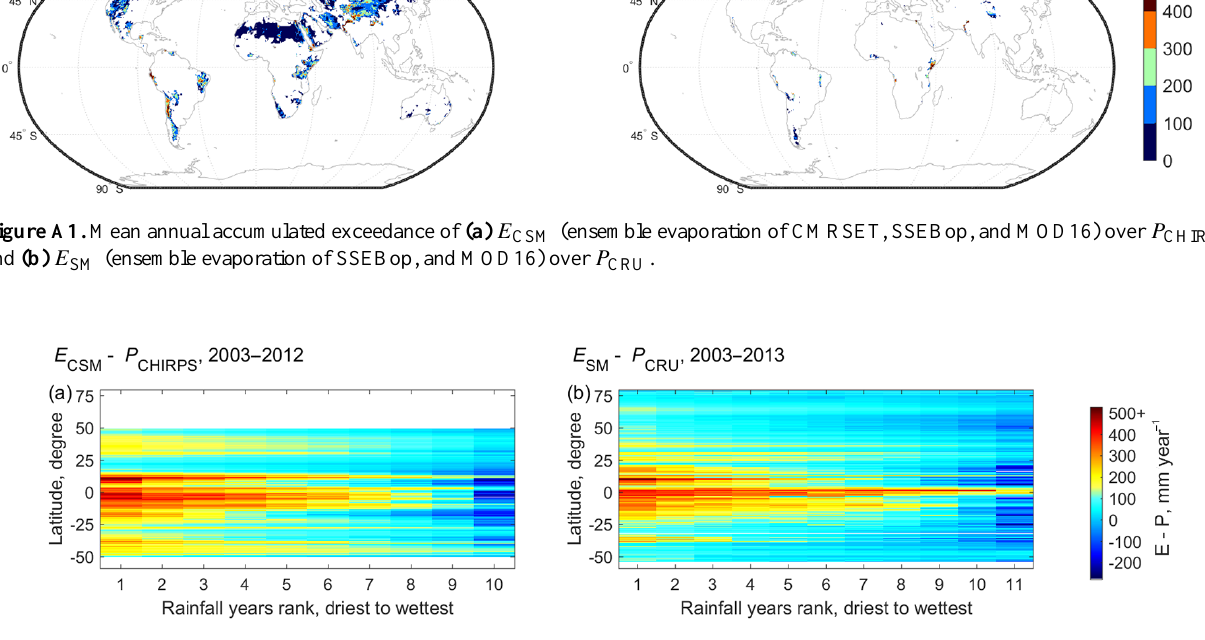
Figure A2. Mean latitudinal difference between (a) E CSM (ensemble evaporation of CMRSET, SSEBop, and MOD16) and P CHIRPS (CHIRPS precipitation), and (b) E SM (ensemble evaporation of SSEBop, and MOD16) and P CRU (CRU precipitation) sorted from the driest to the wettest years. The figure only includes regions where accumulated E − P over the entire available time series (2003–2012 and 2003–2013, respectively) are